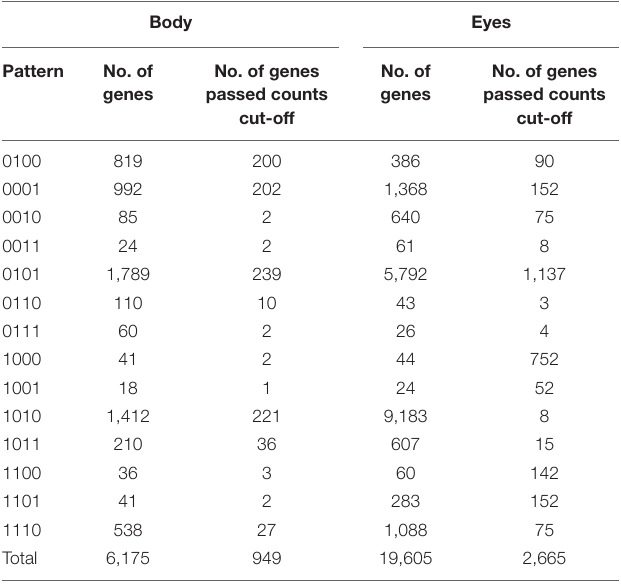
TABLE 2 | Quantity of differentially expressed genes (FDR P < 0.05, linear fold change < − 1.3 or > 1.3) between any stages that matched each binary